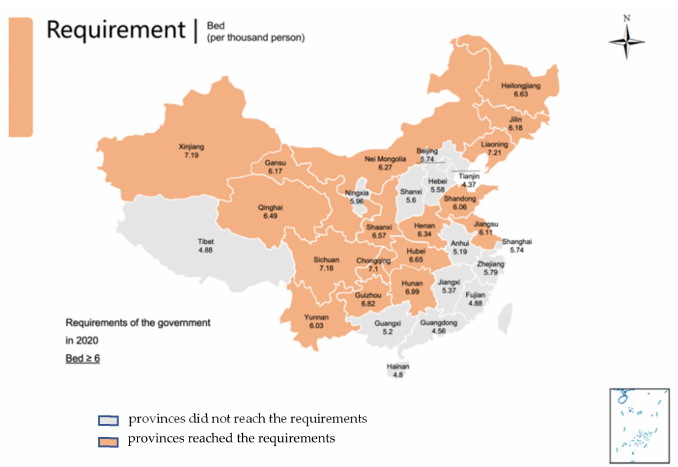
Figure 8. Provinces reached the requirements of the number of beds in 2020 by the government; Provinces did not reach that